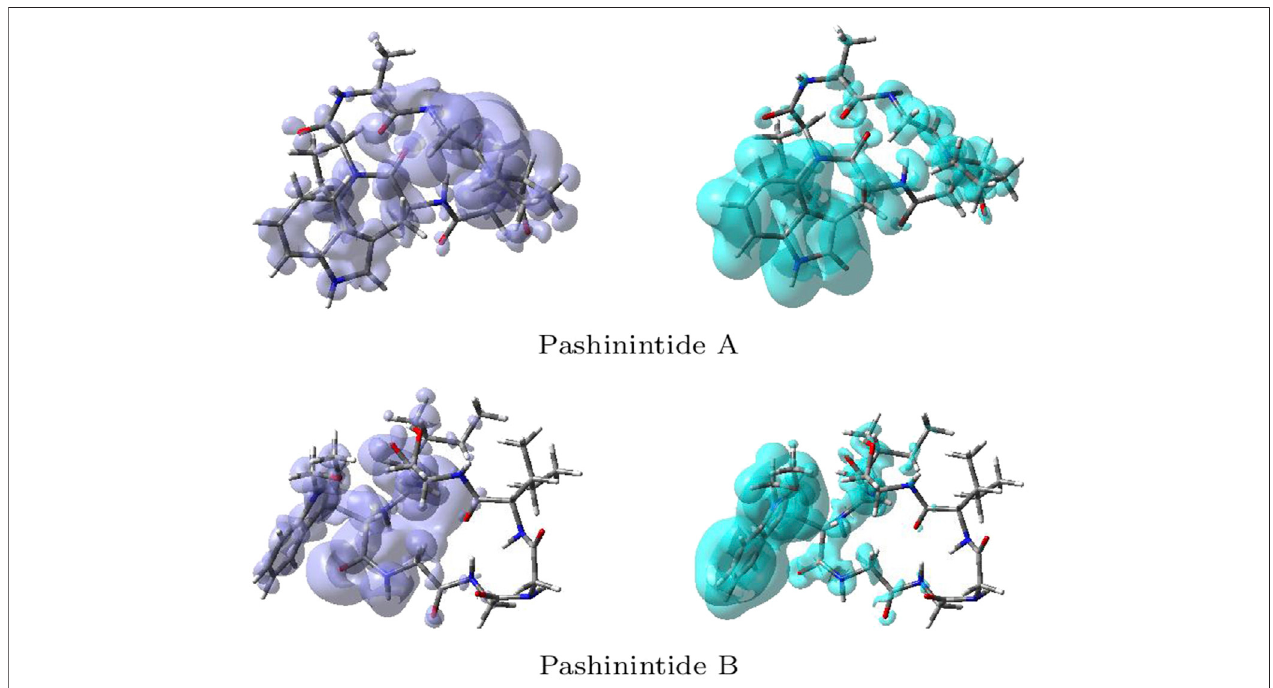
FIGURE 5 | Graphical representations of the dual descriptor DD of the Pashinintides A and B. Left: DD > 0, right: DD < 0.